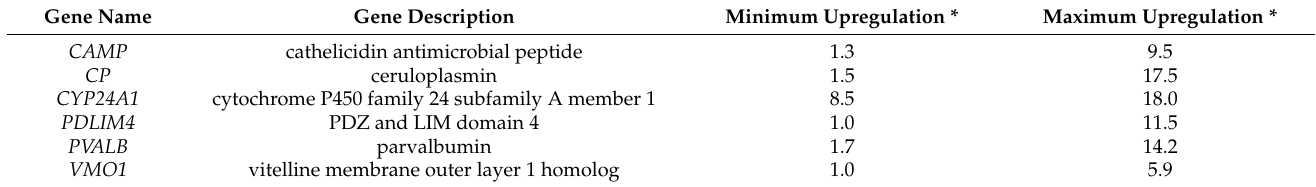
Table 2. Genes upregulated after exposure to 1,25D in the cells from all individuals.